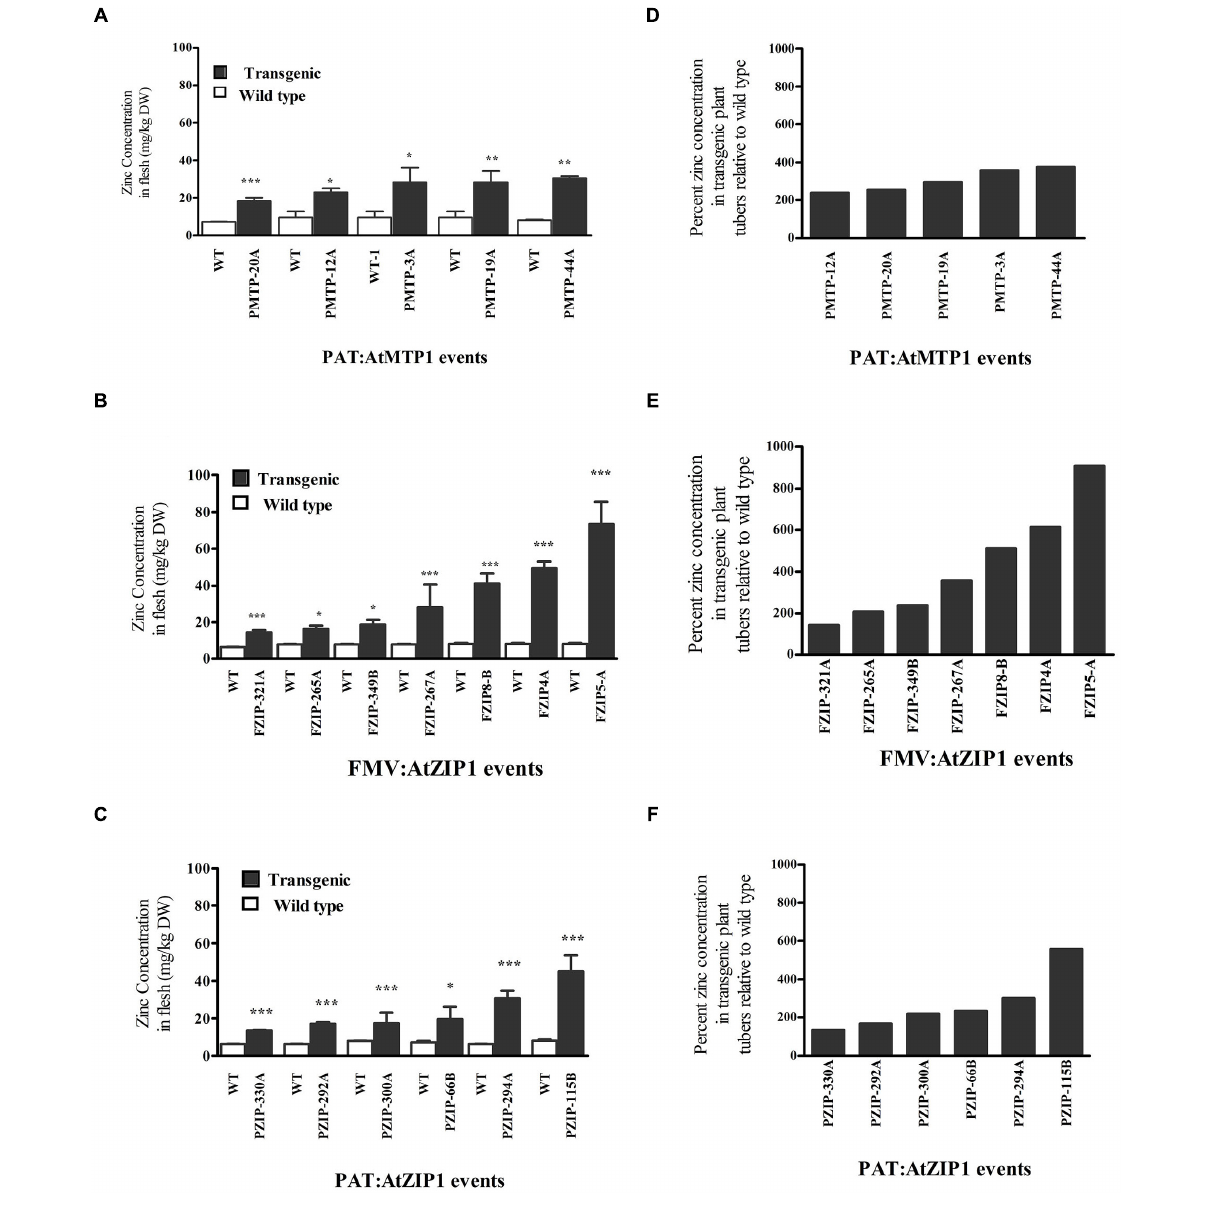
samples, error bars indicate SD. Comparison is between wild type and transgenic events and indicate the different levels of statistical signficance ∗ P < 0.05, ∗∗ P < 0.01, ∗∗∗ P < 0.001. FZIP denotes FMV:ZIP1 lines, PZIP denotes PAT:ZIP1